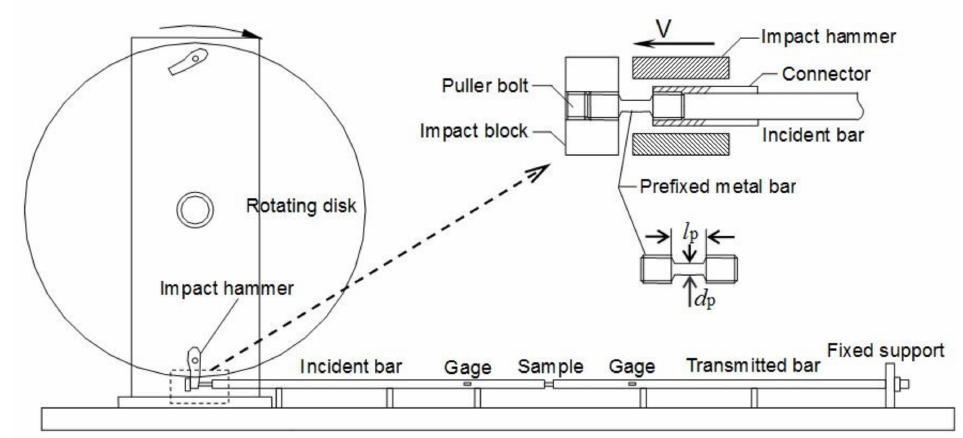
Figure 2. Schematic diagram of the split-Hopkinson tension bar